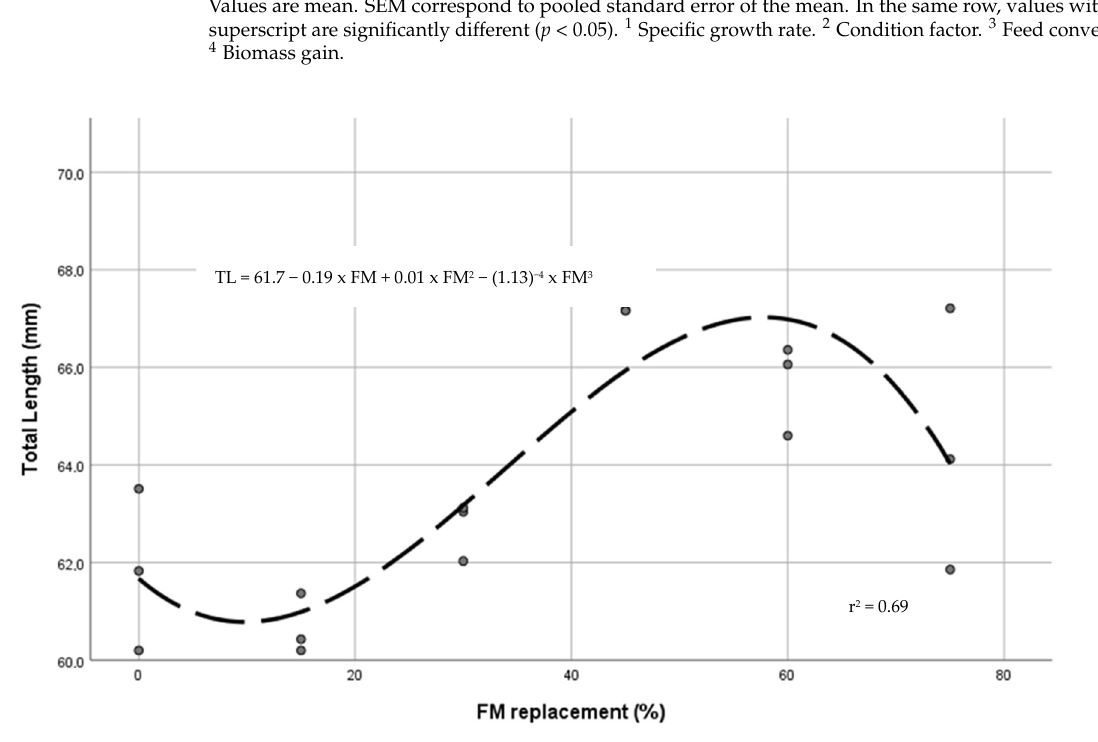
Figure 2. Regression curve between dietary BSFLM and juvenile tench weight (W). The condition factor (K) ranged from 1.27 to 1.38, being significantly higher in tench fed the control diet. Regarding FCR, the lower value (1.08) corresponds to fish fed with the 45% FM substitution. The percentages of fish with externally visible deformities was low, ranging from 0% to 0.04%. Body deformities affected the spinal column and caudal peduncle (break in the tail axis). 3.3. Juvenile Whole-Body Composition The proximate composition and the amino acid profiles of the whole-body of juvenile tench at the beginning and at the end of the study are provided in Table 6. The whole- body lipid content had a significantly linear negative regression (r 2 = 0.80), showing de- creasing values as inclusion of BSFLM increased. Juvenile tench fed the 30%, 45%, 60%,